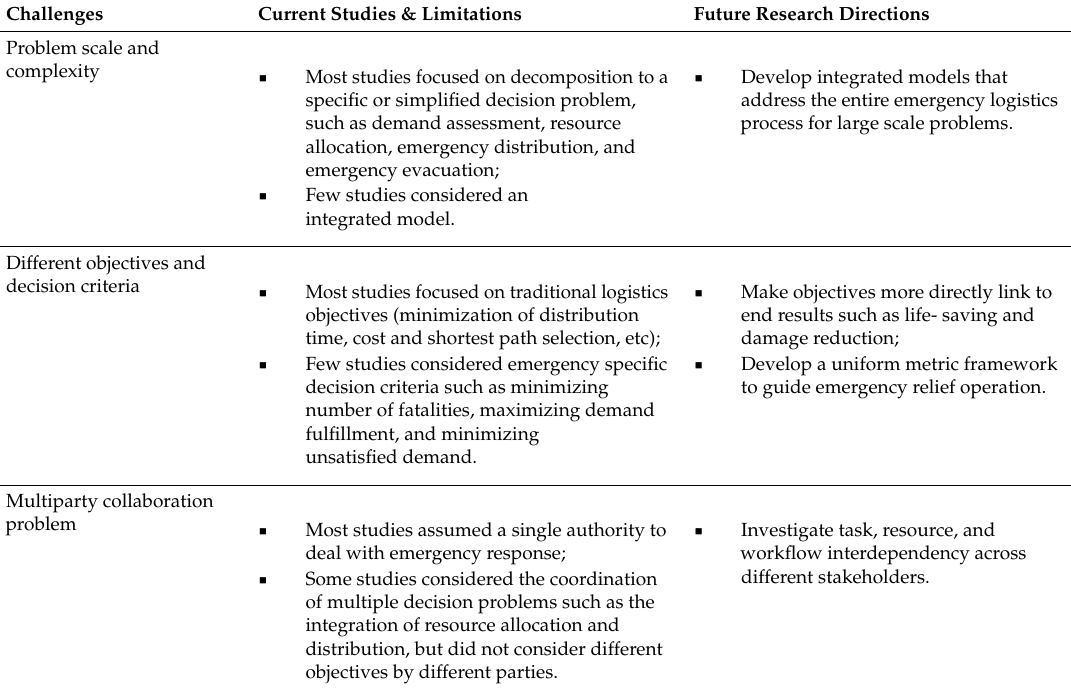
Table 4. Current studies and future research directions in emergency